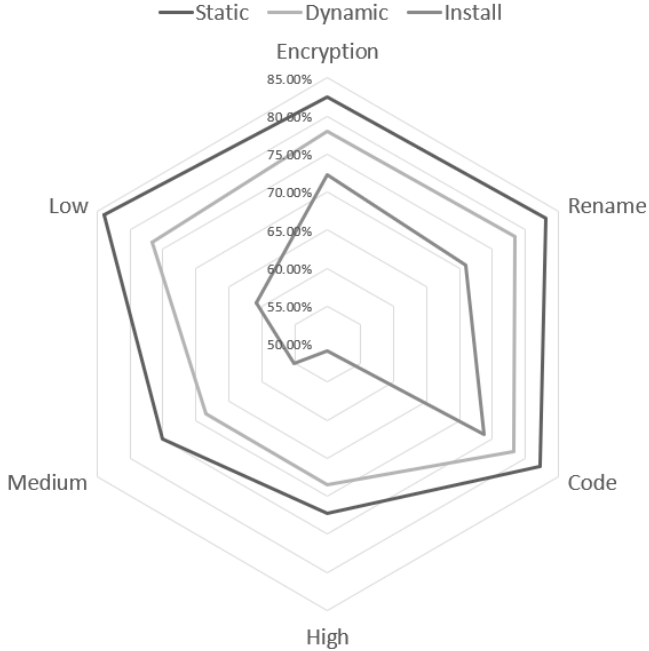
Figure 3. Comparative analysis of Static Analysis, Dynamic Analysis, and Executability of Obfuscated APKs.